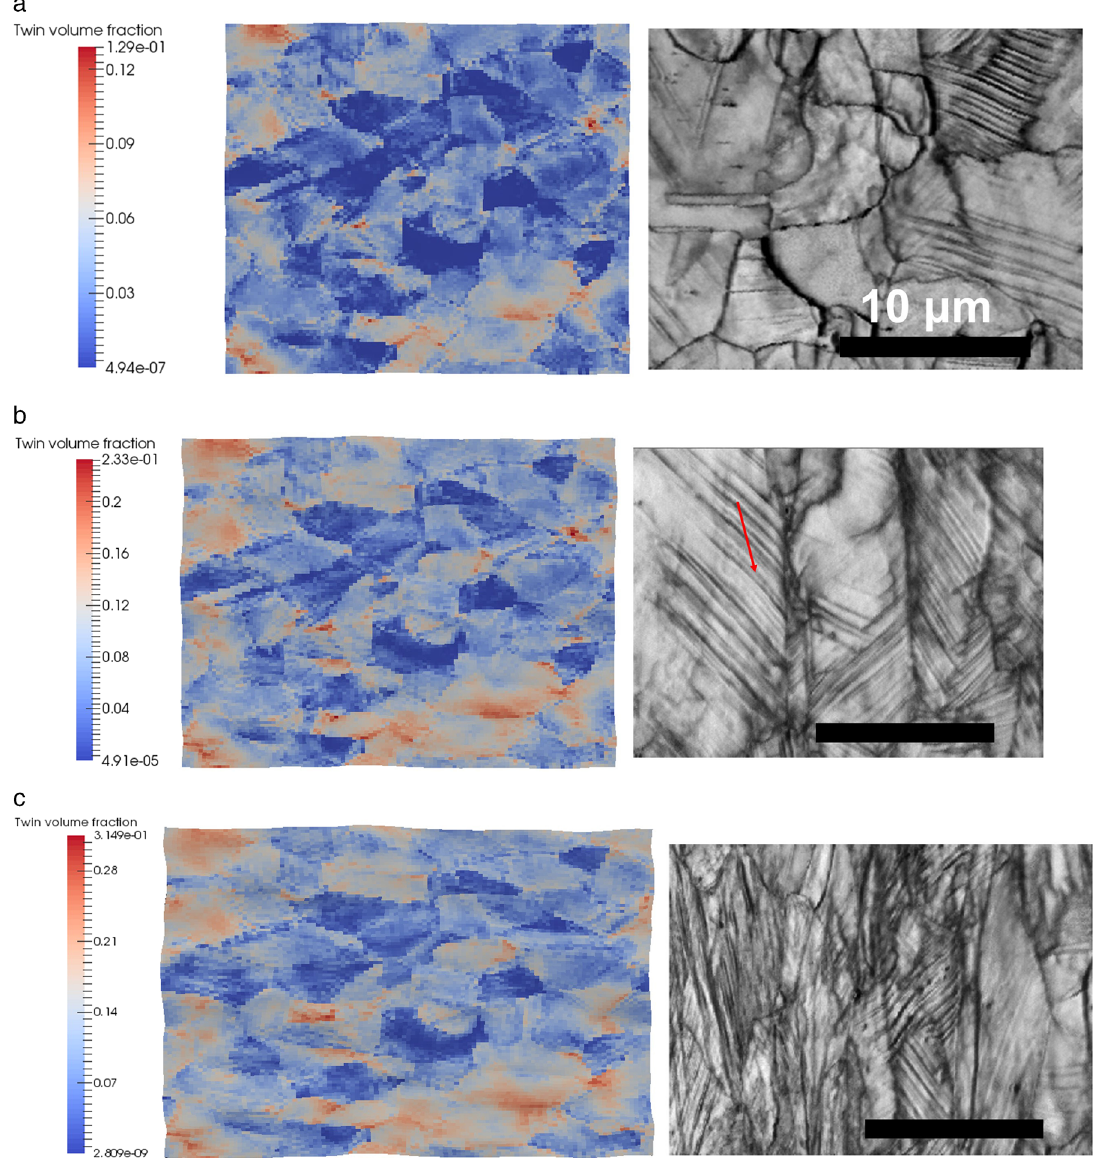
Fig. 2 Simulated ( left ) and experimental ( right ) results on twin volume fraction after tensile deformation. The experimental results are EBSD images based on CI contrast. The scale bar is set to 10 μ m and the applied deformation was a 10%, b 20%, and c 30%, microstructure are generally in good agreement. These features, which are sampled with 624 grains with 110 × 110 × 110, or 1,331,000, grid points, being statistically equivalent to the experimentally observed ones are suf fi cient to deliver realistic microstructures for HRTWIP steels. The details of the experimental characterization and simulation procedures are available in Materials and Methods.